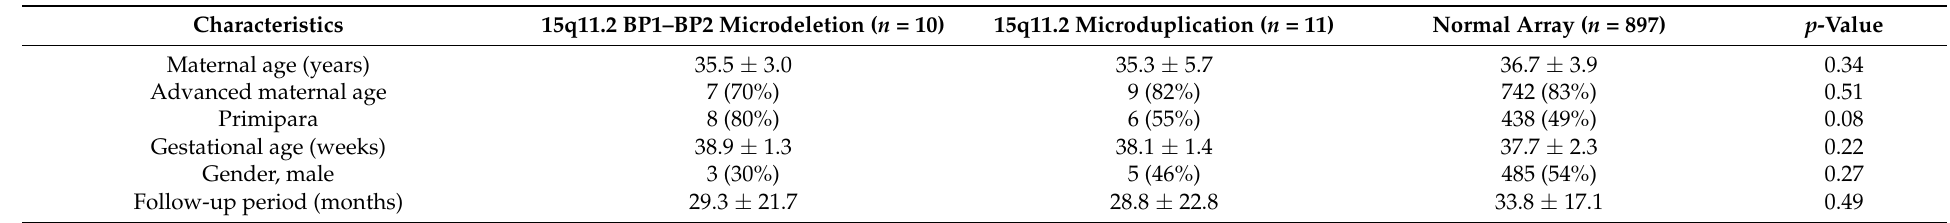
Table 3. Maternal characteristics of amniocentesis of the 15q11.2 CNV groups and the normal array group.